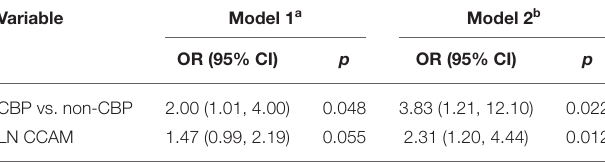
TABLE 2 | Effects of CB exposure on small airway dysfunction.